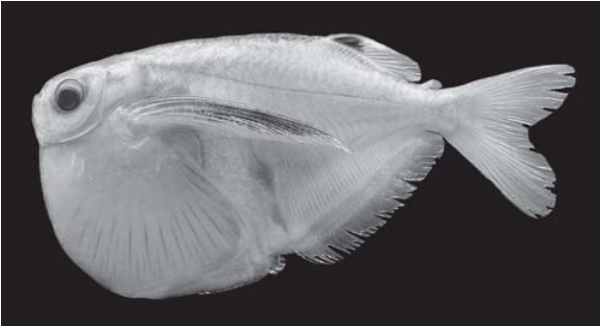
Fig. 2. Voucher specimen of Thoracocharax stellatus (5.54 cm in standard length) from the upper rio Tocantins (MNRJ